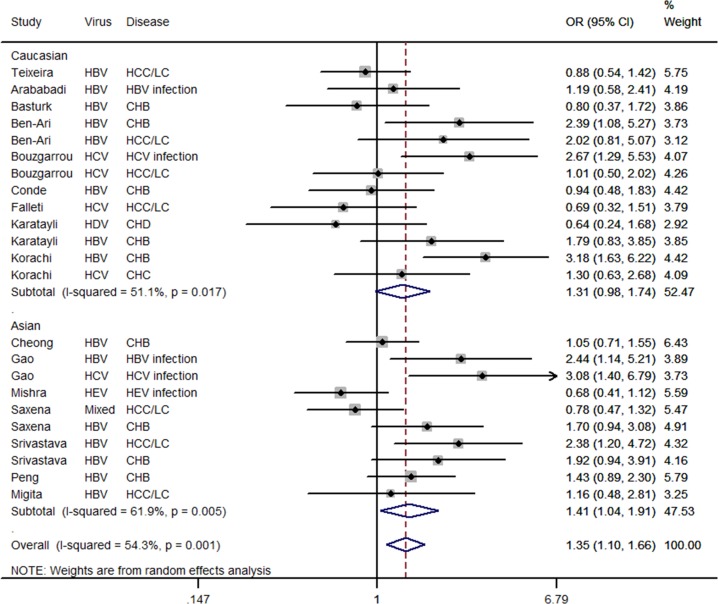
Forest plot for the association between IFN-γ +874T/A polymorphism and hepatitis virus-related diseases risk stratified by ethnicity in a recessive model (AA vs. TT+TA) using a random-effects mode.The squares and horizontal lines correspond to the study-specific OR and 95%CI. The diamond represents the summary OR and 95%CI.